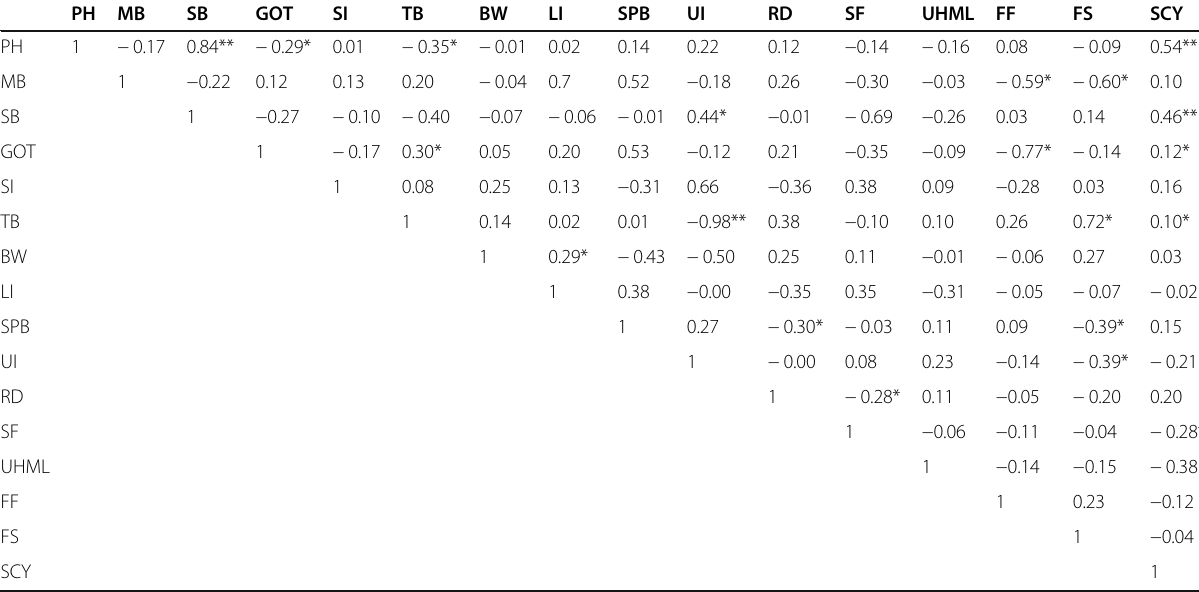
Table 6 Phenotypic correlation coefficient for yield and fiber traits in upland cotton PH MB